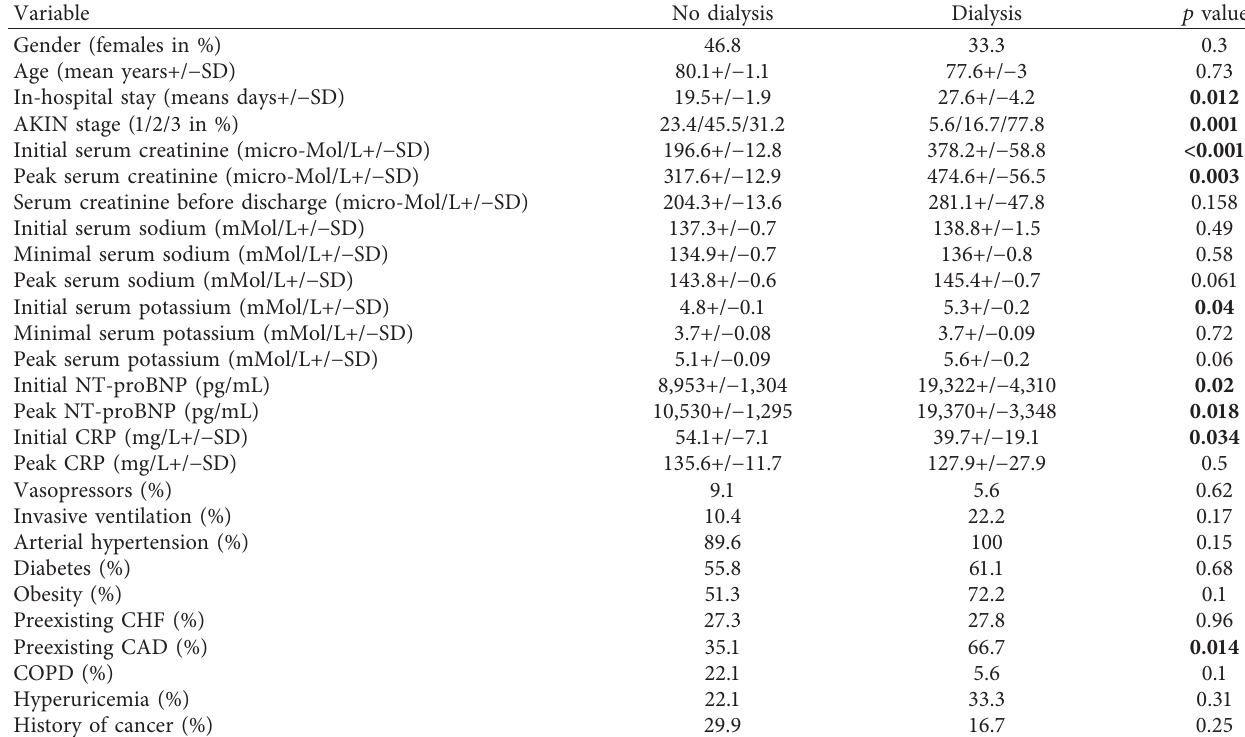
Table 3: Distribution of predefined variables in patients with versus without the need for dialysis therapy.